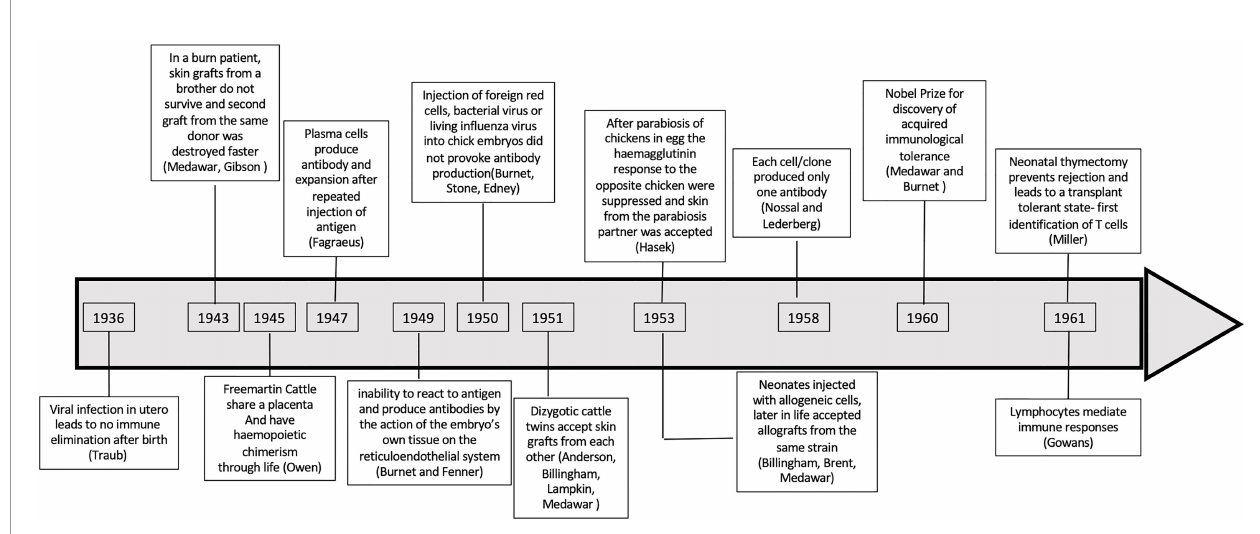
FIGURE 1 | Timeline of observations that supported clonal deletion in utero and in neonates. A chronological representation of studies that led to establishment of clonal deletion to explain